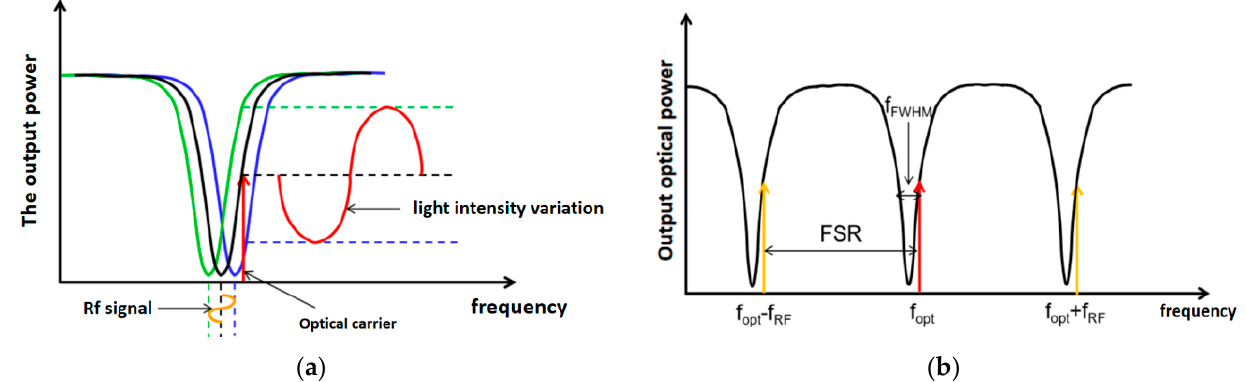
Figure 4. ( a ) Intensity modulation of the microring resonator. The green, black and blue lines show the drift of the resonant wavelength of the material in the microring modulator due to the pockels effect due to the change in RF signal, and the red line shows the change in light intensity as the RF signal is modulated onto the light. ( b ) Mechanisms for setting the parameters of the microring resonator. The red line is the local oscillation light and the yellow line is the sideband of the modulated fi nished RF signal, which carries the RF information.